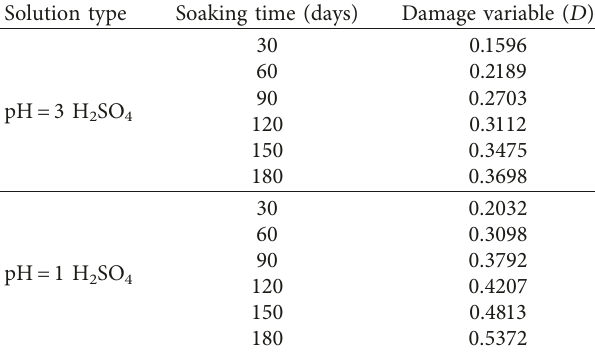
Table 5: Damage variables of the intermediate scanning layer of the sandstone samples at different time intervals in different